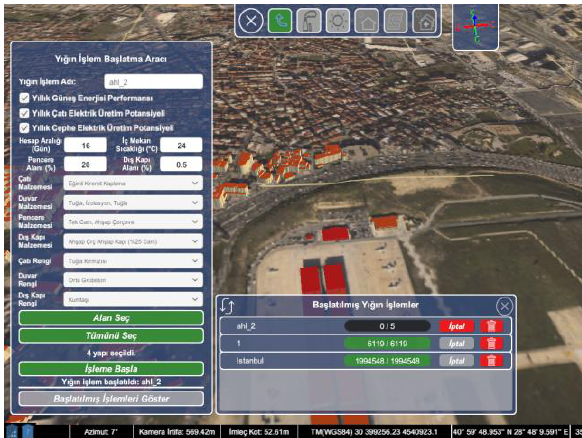
Figure 13. Solar estimation for the selected building rooftop and façade (potential solar panel).